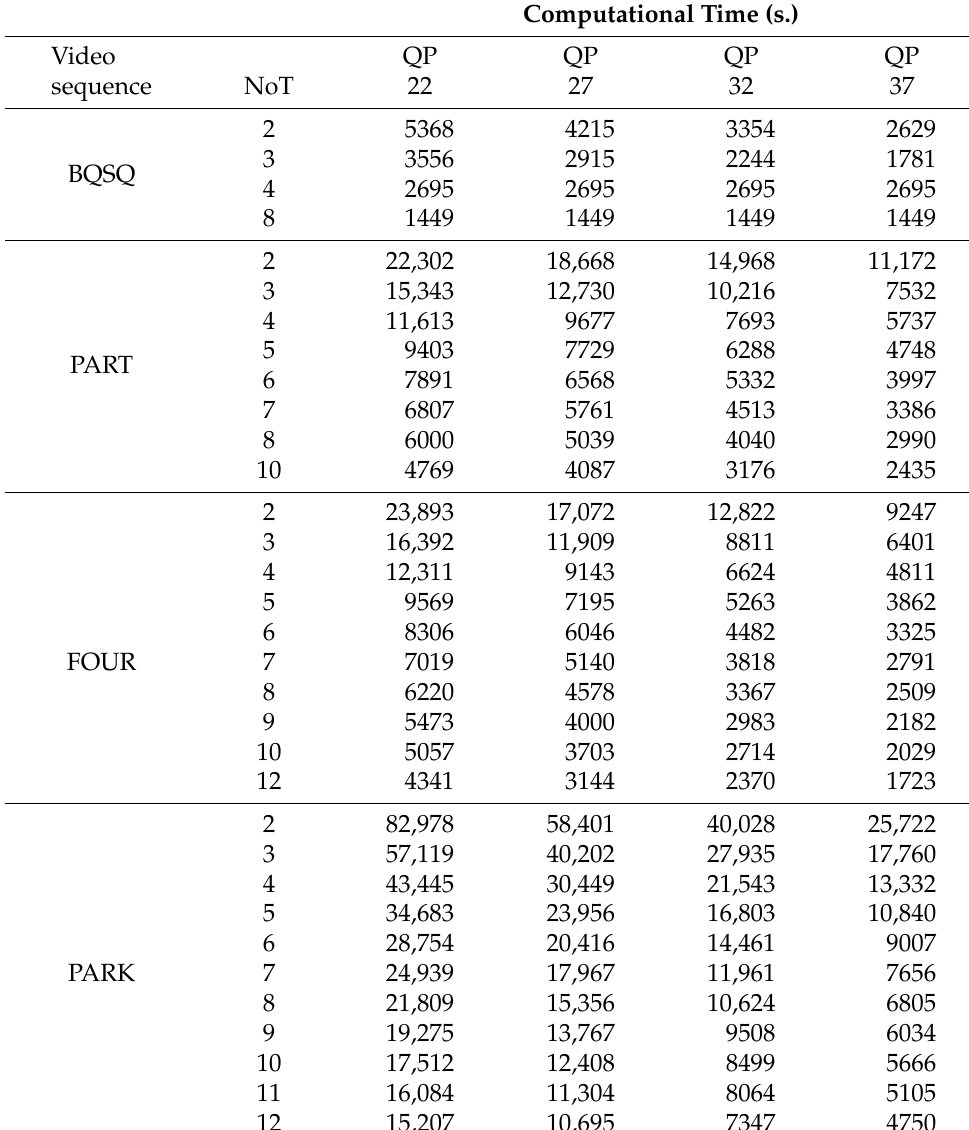
Table 15. Computational times (s.) for Algorithm JEM-SP-ASync.